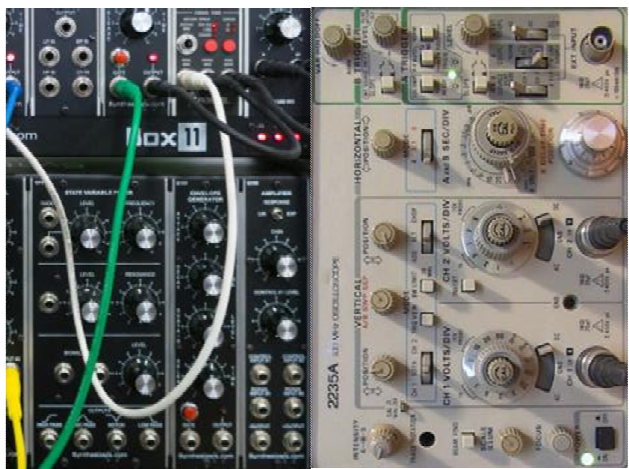
Figure 3. Synthesizer ( left ) and oscilloscope ( right ).